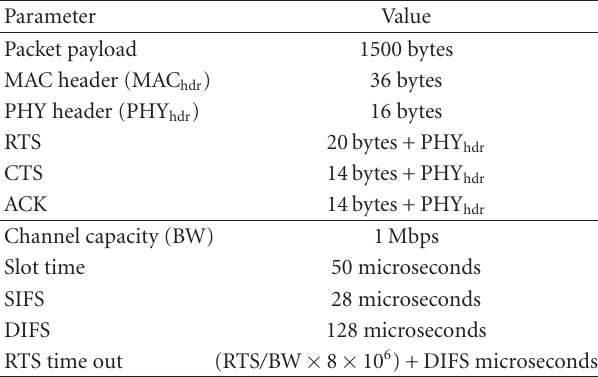
Table 3: FHSS system parameters for IEEE 802.11e used to obtain numerical results.